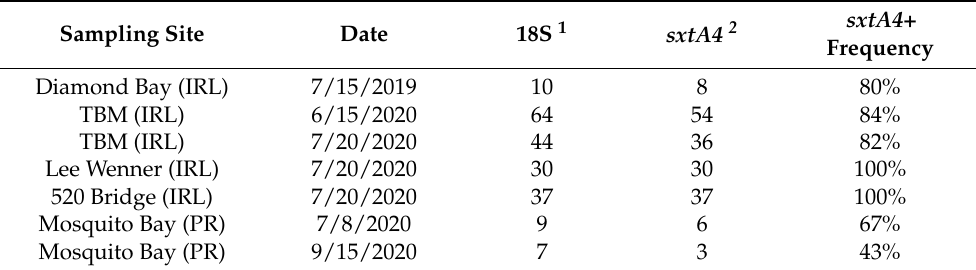
Table 3. sxtA4 + genotype frequencies from sites in Florida (IRL) and Puerto Rico. 1 indicates number of isolated cells yielding an 18S rRNA gene amplicon. 2 Number of isolated cells yielding the 18S rRNA gene amplicon in which sxtA4 was detected.